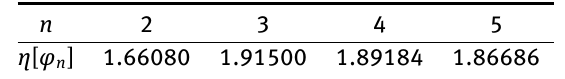
Table 5: The values of the η [ φ n ] for n = 2, 3, 4, 5 .